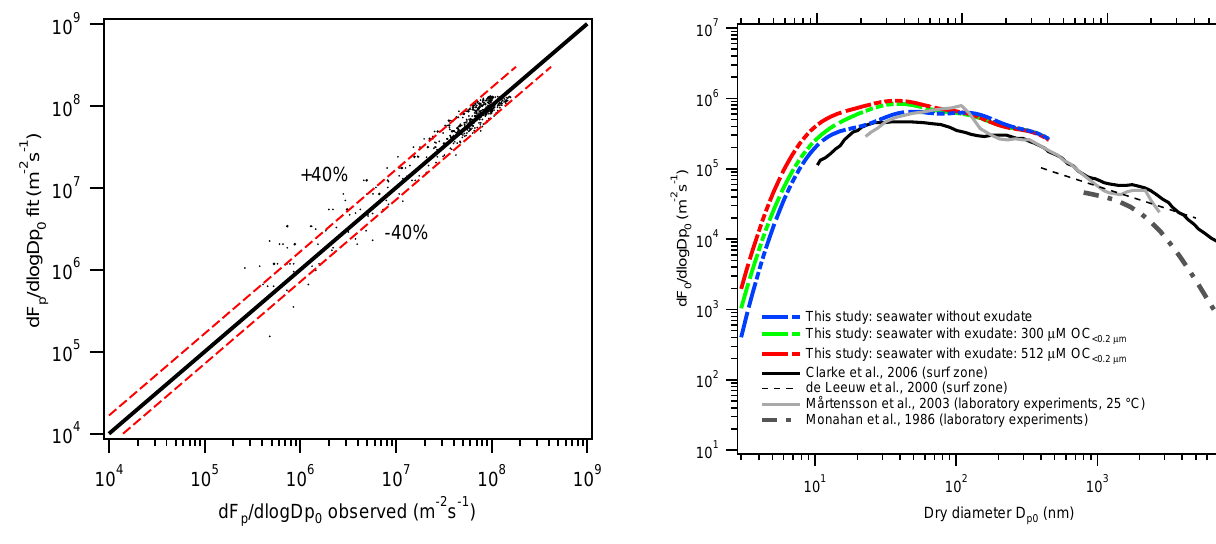
Fig. 13. Correlation between experimental and derived particle flux using the parameterisation defined by Eqs. (1–4). The relative error indicated corresponds to the maximum deviation within the 95% limits.